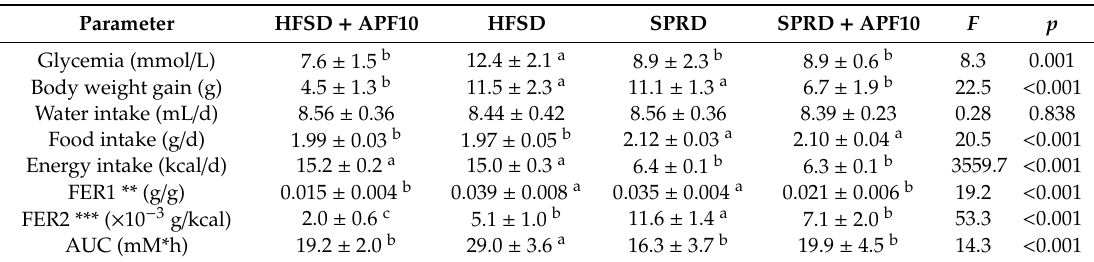
Table 5. Effect of 150 days of high-fat and sucrose diet with 10 mg of APF supplementation (HFSD + APF10) on glycaemic status food, body weight gain, water, food and energy intake, food efficiency ratio per food (FED1) and per energy intake (FED2), and glucose tolerance in OGTT (AUC) of C57BL / 6J mice in comparison to HFSD without APF addition (HFSD) and to the standard pellet rodents diet with (SPRD + APF10) and without the addition of APF